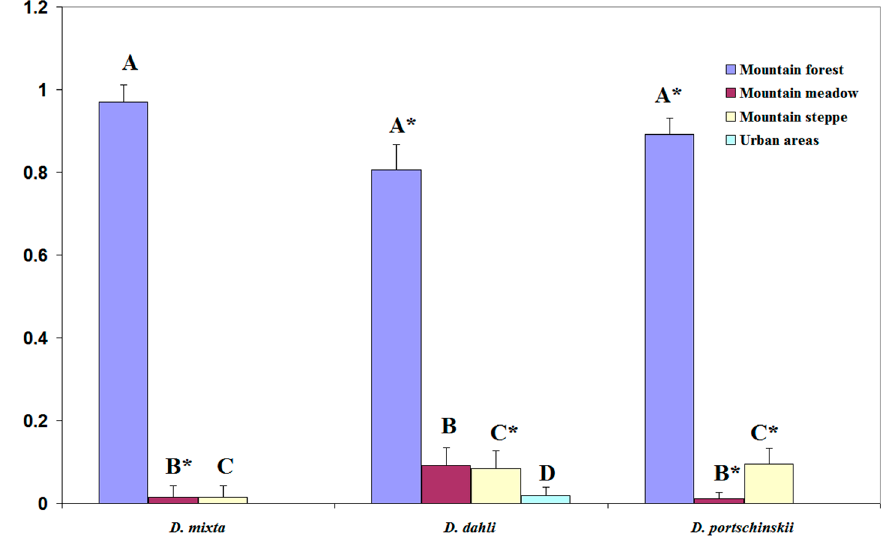
Figure 4. The percentage of preferred vegetation types with 95% Wald’s confidence intervals. A multiple comparison was performed using the Chi-square (a: 13.4, DF = 2, p = 0.001; b: 17.7; DF = 2, p << 0.001; c: 5.9, DF = 2, p = 0.05; d: 5.84, DF = 2, p = 0.05) and Tukey’s Post hoc tests. Absence of significant differences between the means was designated *.